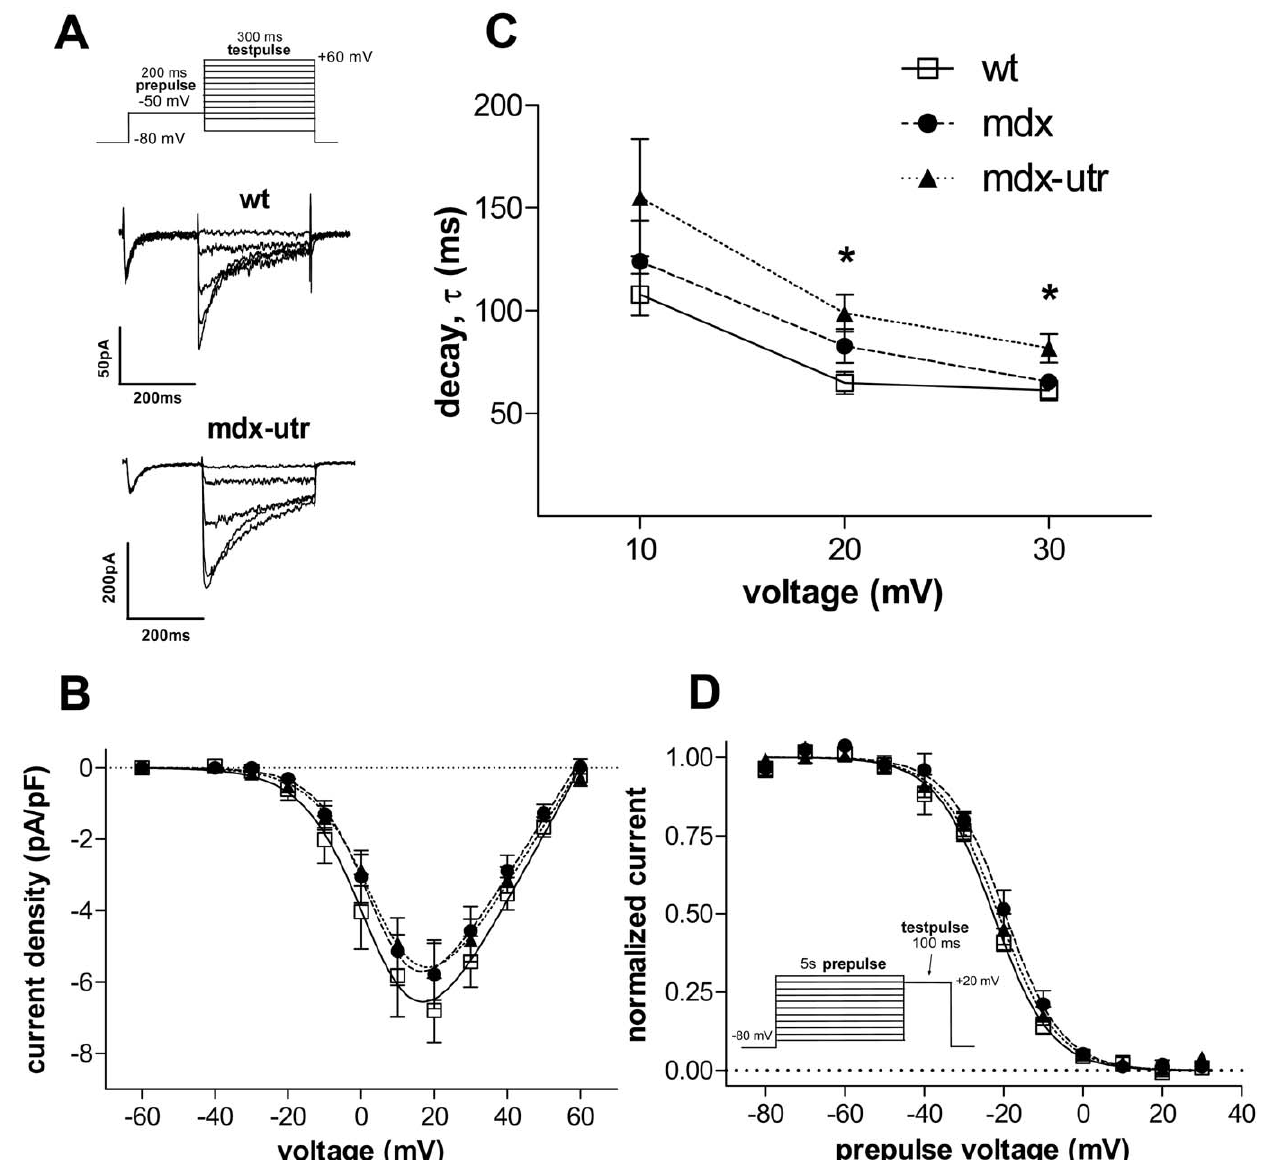
Figure 2. Calcium channel properties in wt and dystrophic neonatal cardiomyocytes. A. Original barium current traces (five episodes displayed) of a wt and mdx-utr cardiomyocyte, elicited by the pulse protocol on top. The prepulse was used to eliminate currents through T-type calcium channels. B. Current-voltage relationships derived from a series of experiments on wt and dystrophic cardiomyocytes as shown in A. C. Comparison of the current decay kinetics between wt and dystrophic cardiomyocytes at various membrane voltages. t –values were derived from single exponential fits of the current decay after channel activation. * indicates a significant difference (ANOVA, p , 0.05) between the three tested groups. Tukey’s Post Hoc test revealed a significant difference (p , 0.05) between mdx-utr and wt, but not between mdx-utr and mdx. D. Voltage- dependency of steady-state inactivation in wt and dystrophic cardiomyocytes. For n-values see Table 1.